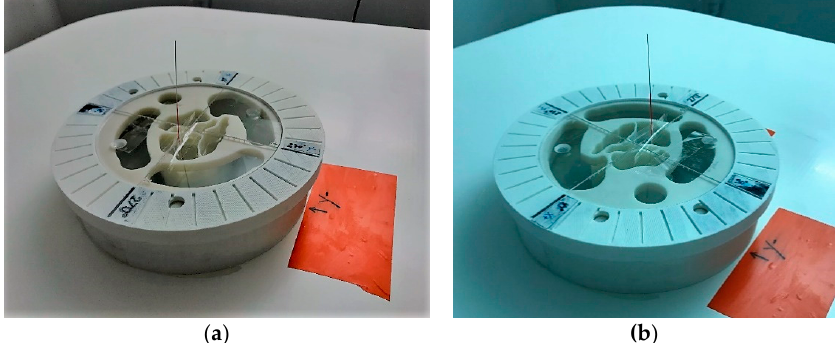
Figure 12. Breast phantom ready for the microwave imaging test: examination table top view ( a ) Breast phantom rotational position #1; ( b ) Breast phantom rotational position #2.